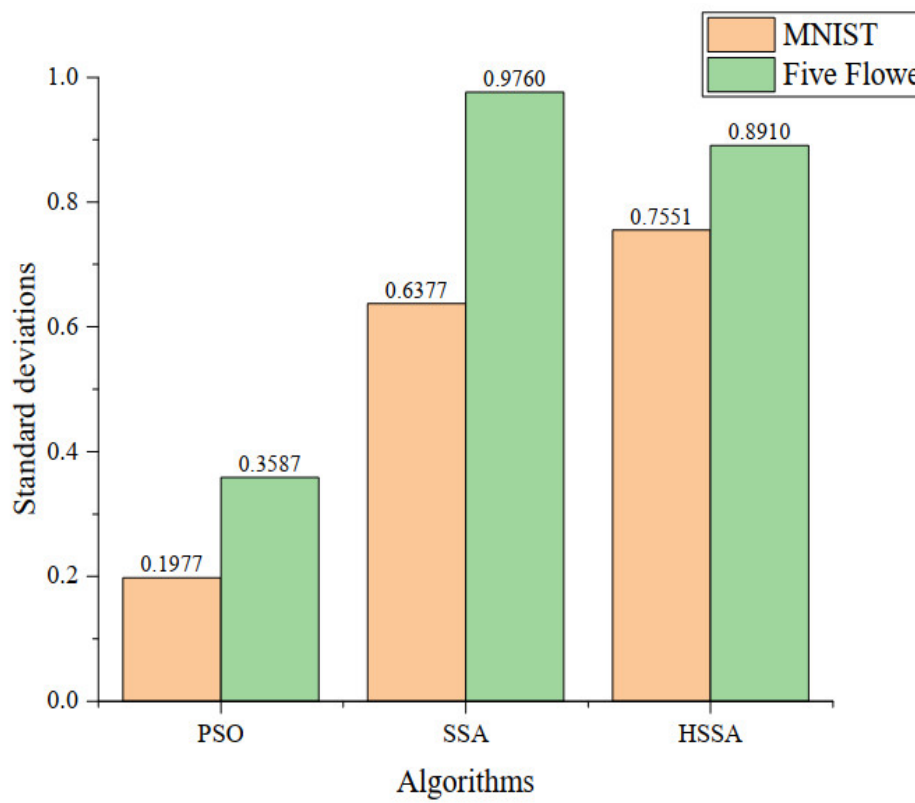
Figure 10. Standard deviations of PSO, SSA, and HSSA.